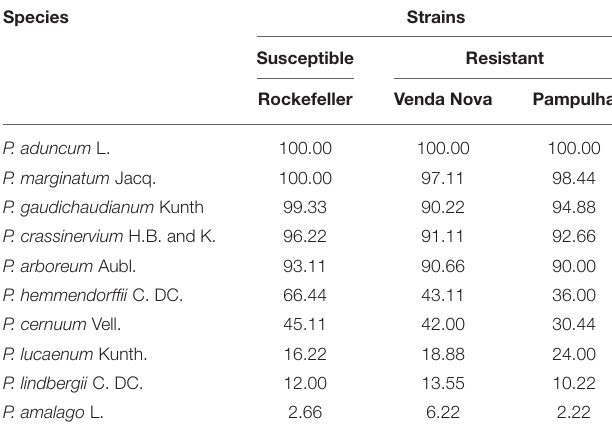
TABLE 3 | Mortality percentage of Aedes aegypti larvae in resistant and susceptible strains to pyrethroids treated with essential oils of Piper species. Species Strains Susceptible Resistant